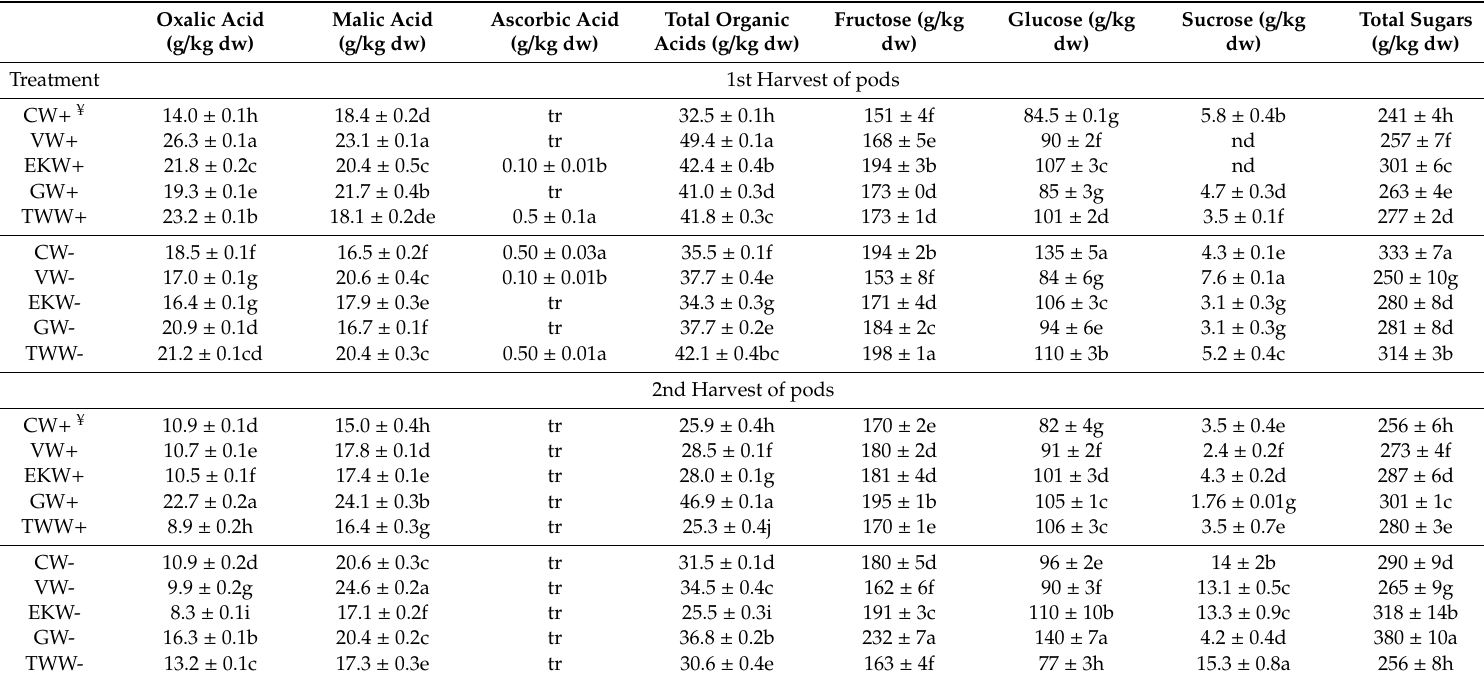
Table 6. Composition in organic acids and sugars of the studied pods and seeds of beans in relation to the irrigation regime (mean ±